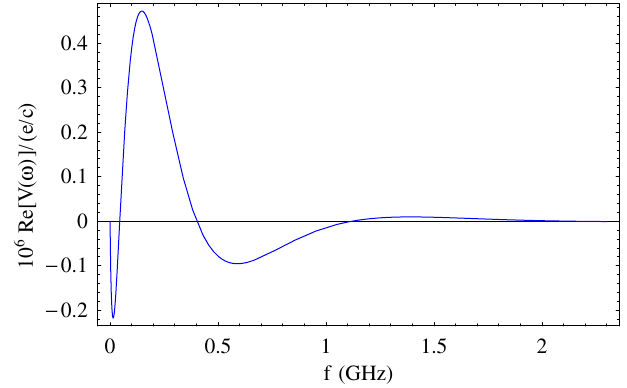
FIG. 5. (Color) Radial dependence of the m ¼ 1 harmonics of B (cid:7) ð r Þ within the wall for (a) (cid:1) ¼ 0 : 01 cm , (b) (cid:1) ¼ 0 : 2 cm , and (c) (cid:1) ¼ 0 : 5 cm . The vertical lines correspond to the radius a þ (cid:1) . Note the difference in scale. Other parameters are given in the text.